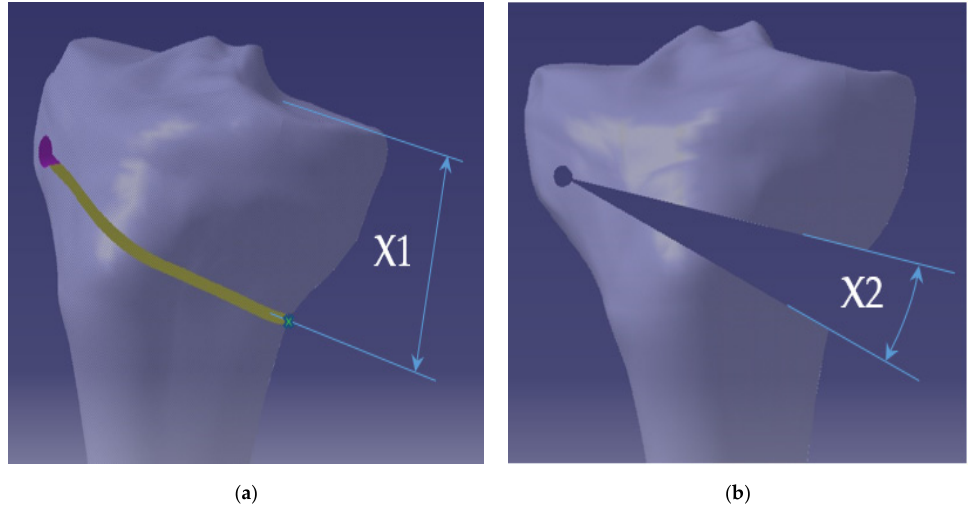
Figure 2. Analyzed geometric parameters: ( a ) position of the cutting point; ( b ) the value of the correction angle.